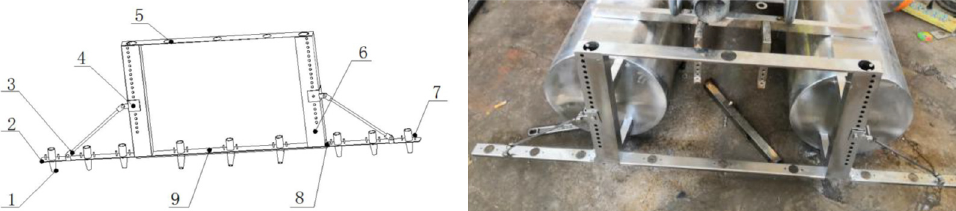
Figure 4. The hydraulic flushing device: (1) nozzle, (2) folding board, (3) pull rod, (4) slider mecha- nism, (5) nozzle upper plate, (6) distance adjustable rail guide, (7) screw, (8) hinge, (9) fixed nozzle plate.